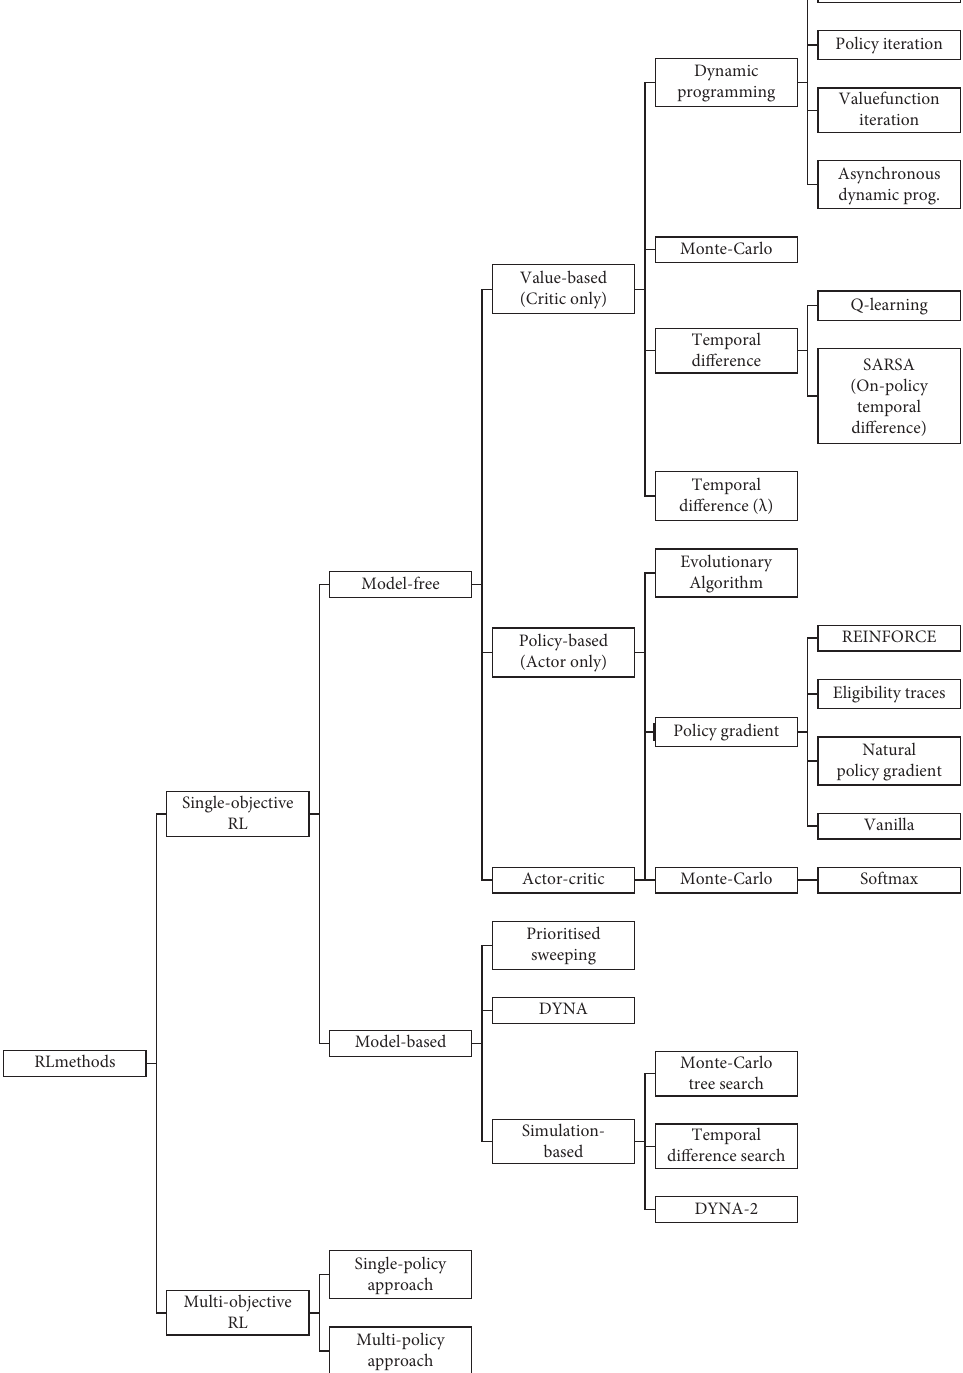
Figure 3: Classification tree of reinforcement learning